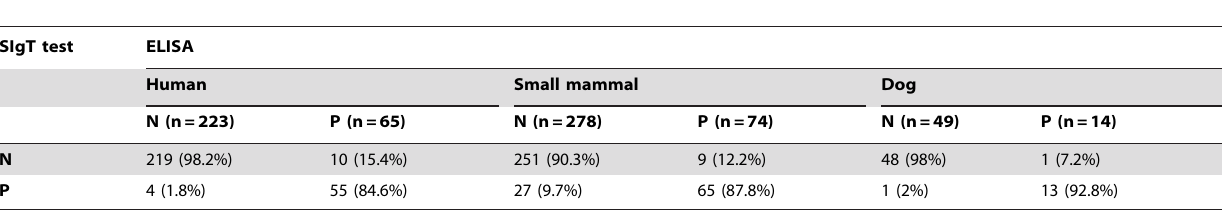
Table 1. Comparison of SIgT test and ELISA for human, small mammal and dog serum